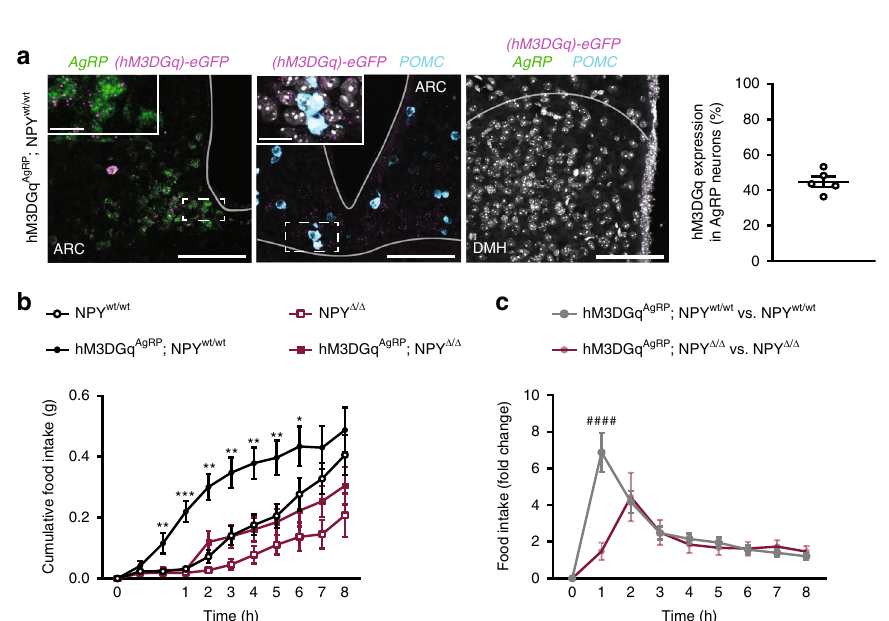
Fig. 5 Virally transduced re-expression of NPY selectively in AgRP neurons of NPY knockout mice restores the feeding response and insulin resistance upon optogenetic activation of AgRP neurons. a Microphotographs show the successful expression of bilaterally delivered control virus (AAV- DIO-mCherry) in ChR2 AgRP ; NPY wt/wt and ChR2 AgRP ; NPY Δ / Δ mice, and NPY virus (AAV-DIO-NPY) in ChR2 AgRP ; NPY Δ / Δ mice in the ARC. Note the presence of NPY containing fi bers in the PVH of ChR2 AgRP ; NPY Δ / Δ mice re-expressing NPY, which is absent in the corresponding control. In contrast, the supplementary somatosensory area of the cortex (SSs), which receives no projections from the ARC, displays NPY labeling only in ChR2 AgRP ; NPY wt/wt mice. Scale bar = 200 µ m. b , c Cumulative and total food intake upon AgRP neuronal stimulation in virally transduced NPY-de fi cient and wildtype control mice (mCherry) and in NPY-de fi cient mice re-expressing NPY in the ARC. d , e Blood glucose levels upon AgRP neuronal activation during insulin tolerance tests and corresponding area under the curve (AUC) in virally transduced NPY-de fi cient and wildtype control mice (mCherry) and in NPY-de fi cient mice re-expressing NPY in the ARC. n = 10 and n = 7 mice for ChR2 AgRP ; NPY wt/wt and ChR2 AgRP ; NPY Δ / Δ injected with mCherry virus and n = 6 mice for ChR2 AgRP ; NPY Δ / Δ injected with NPY virus. Data are shown as mean ± s.e.m. Statistical analysis is represented by * p ≤ 0.05, # p ≤ 0.05, ## p ≤ 0.01, ### p ≤ 0.001, and #### p ≤ 0.0001 as determined by two-way ANOVA (panels b – d ) followed by Tukey post hoc test, or one-way ANOVA (panel e ) followed by Tukey post hoc test. In panels b and d , # represents comparisons between NPY re-expressing mice and NPY-de fi cient mice injected with control virus. Source data are provided as a Source Data fi le.